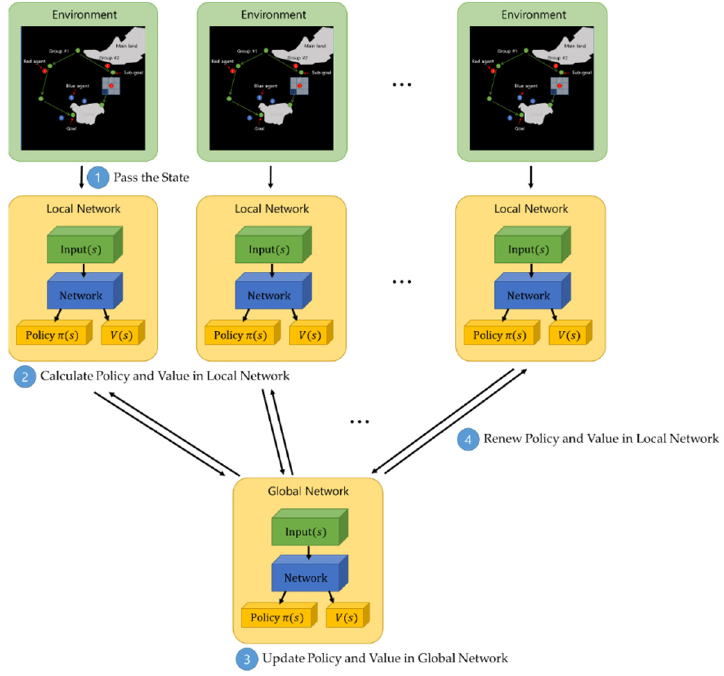
Figure 2. Structure of the A3C algorithm.